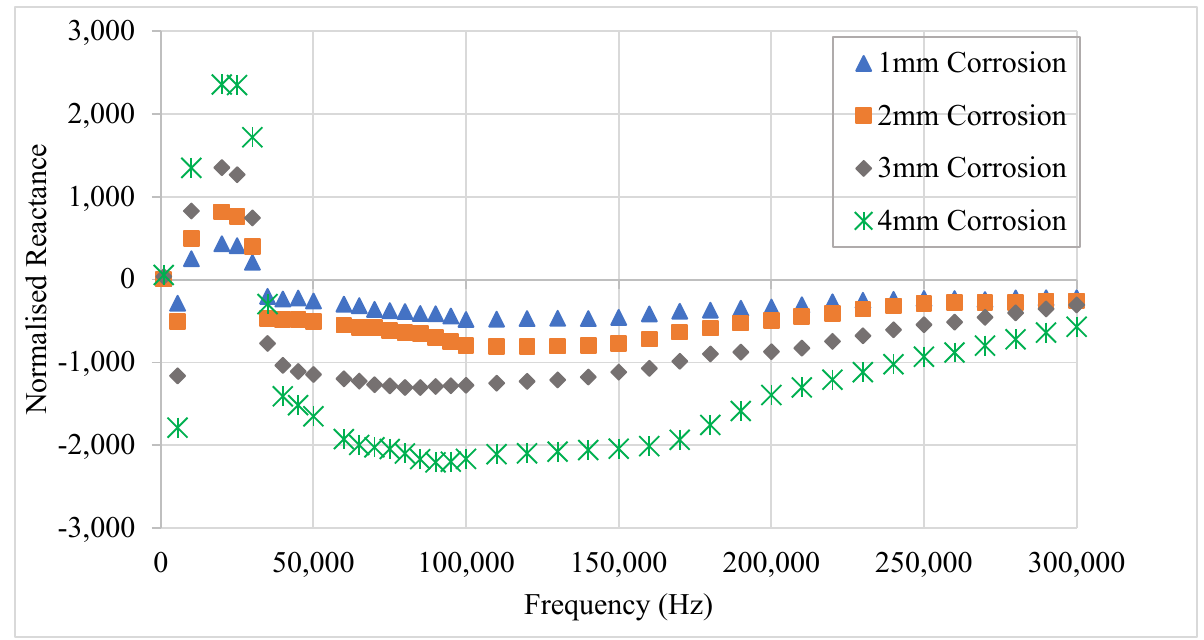
Figure 8. The normalized reactance for steel plates with different thicknesses obtained from experi- ment.